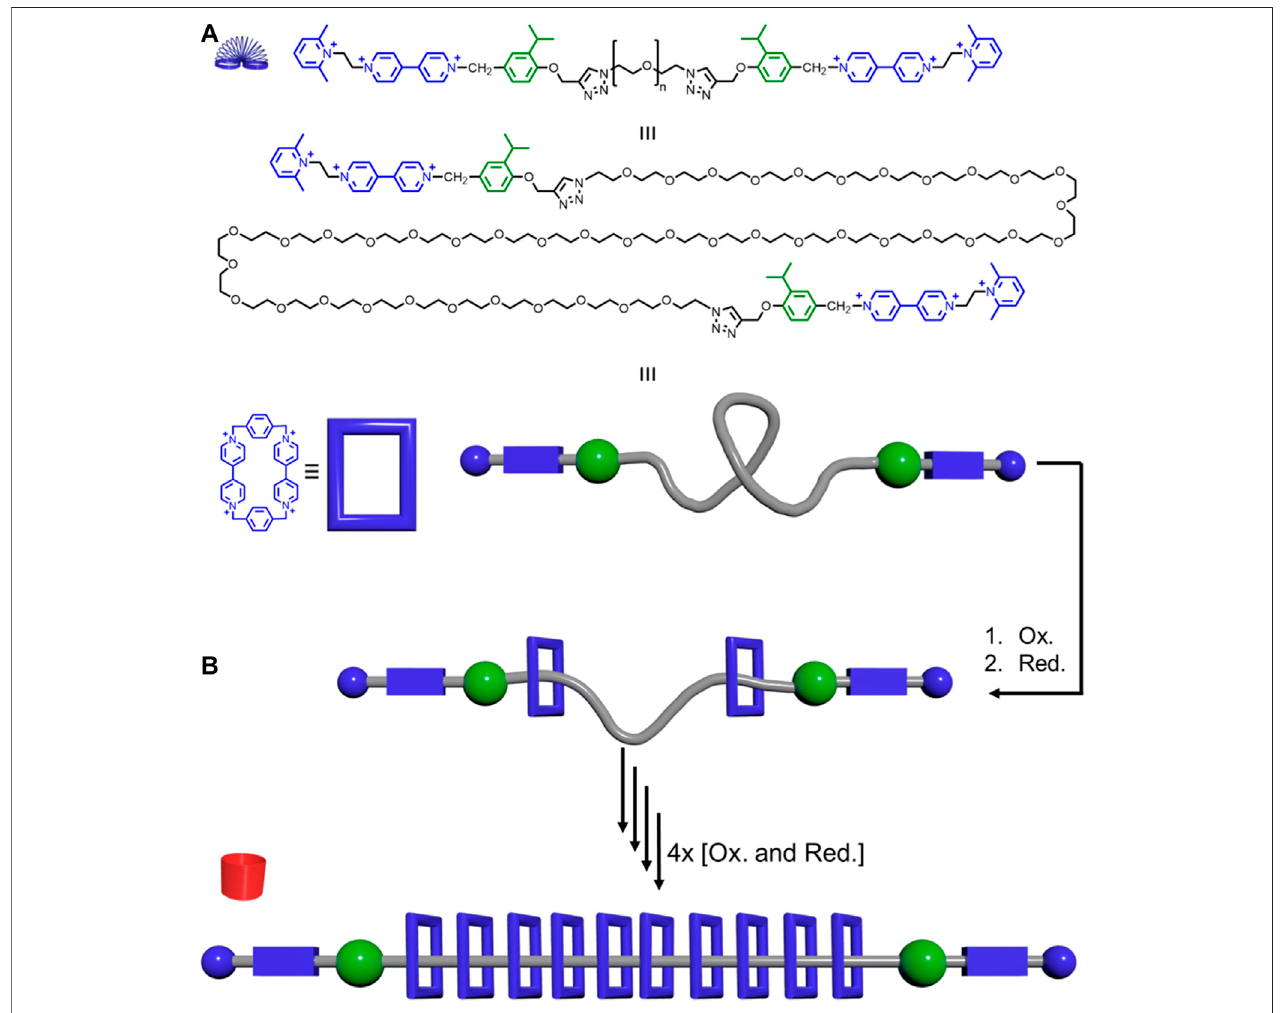
FIGURE13| Precisepolyrotaxanepumpsynthesizer: (A) Threadstructure(top),elongatedversion(middle),andmodeltogetherwiththestructureoftheCBPQT 4+ macrocycle (blue) and its model. (B) Pumping of the macrocycles onto the thread generates rotaxanes that get more rigid as more CBPQT 4+ macrocycles are added.